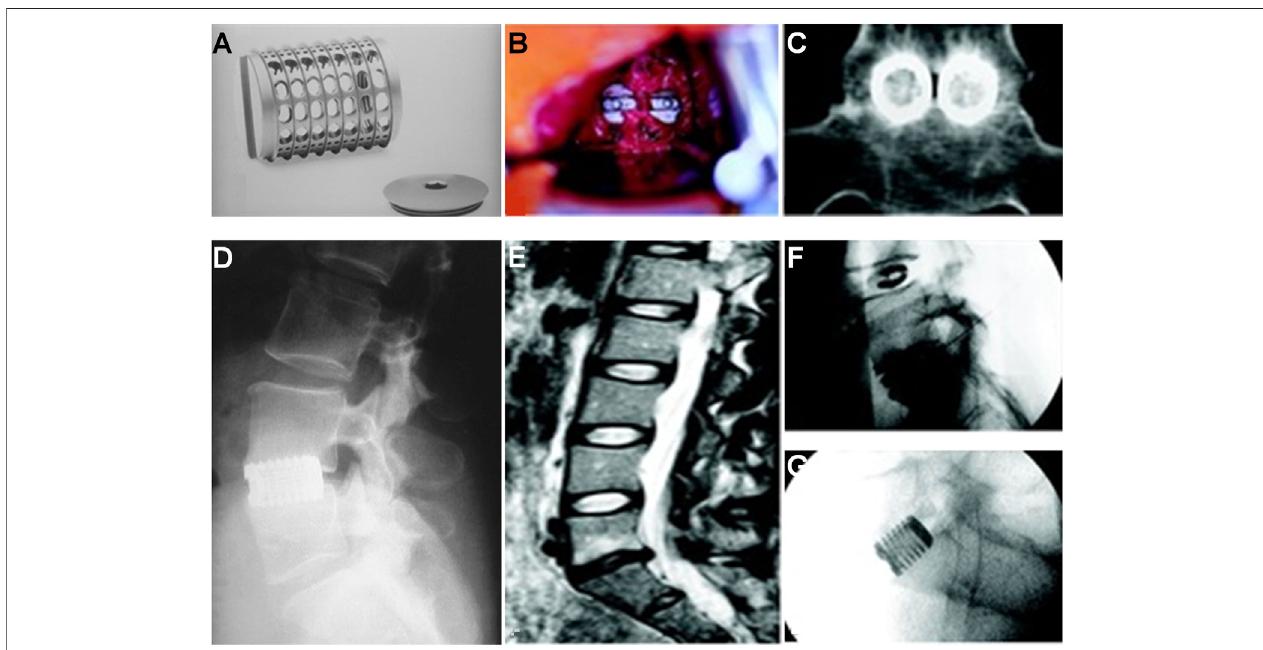
FIGURE 1 | (A) INTER FIX threaded fusion device. (B) Intraoperative picture of the two cages implanted at the L5 – S1 interspace. (C) Coronal CT scan 1 year postoperative. Bone has grown through and around the cages. (D) Lateral radiograph of INTER FIX. (E) Preoperative sagittal T2-weighted MRI with degeneration of the L5 – S1 disc and a normal L4 – L5 disc. (F) Discogram with morphologic abnormality of the L5 – S1 disc and a large posterior anular tear. The L4 – L5 disc is anatomically normal.Exactconcordant10/10pain wasreproduced at L5 – S1.TheL4 – L5 injectioncausednopain. (G) Postoperative lateralradiograph withINTERFIX cages in good position (Sasso et al.,